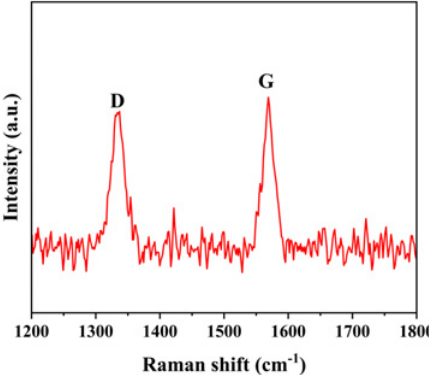
Fig. 10 Raman spectra of worn surface at